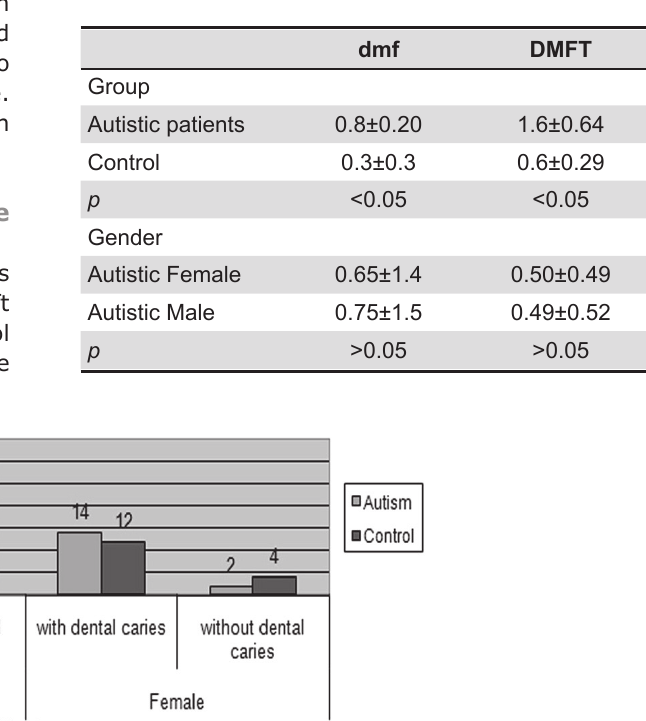
Table 1- Mean decayed, missing and filled teeth (dmft/ DMFT) scores of the autism group and healthy control subjects. Data are presented as mean ± standard deviation